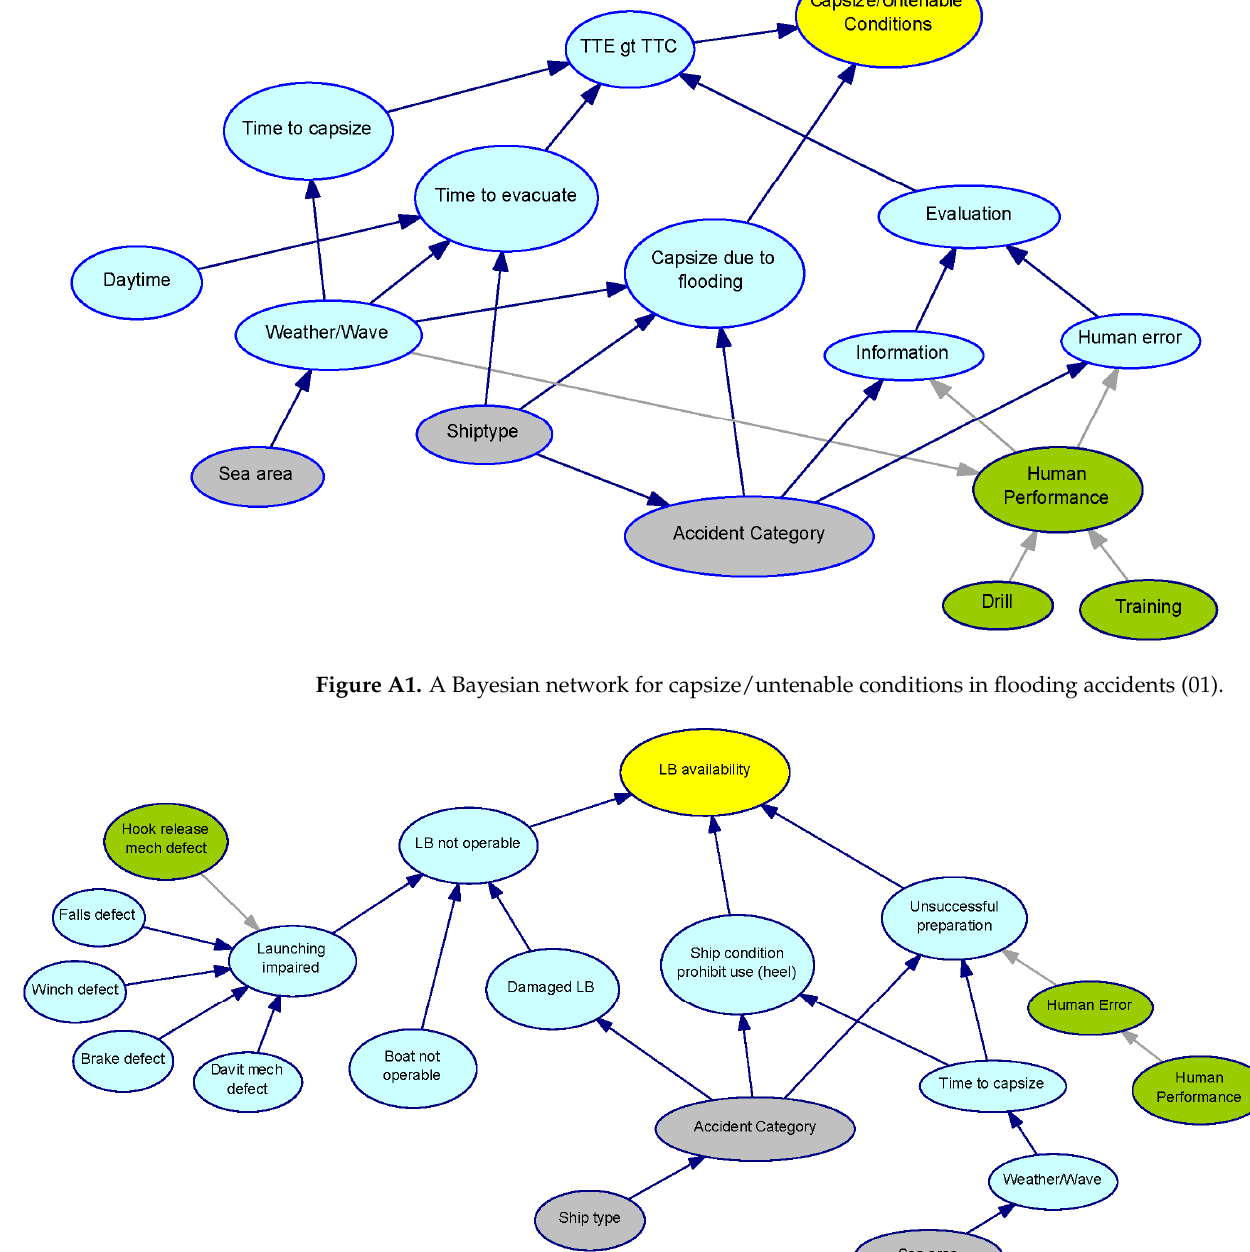
Figure A2. A Bayesian network for lifeboat availability in flooding accidents (03 FL ).